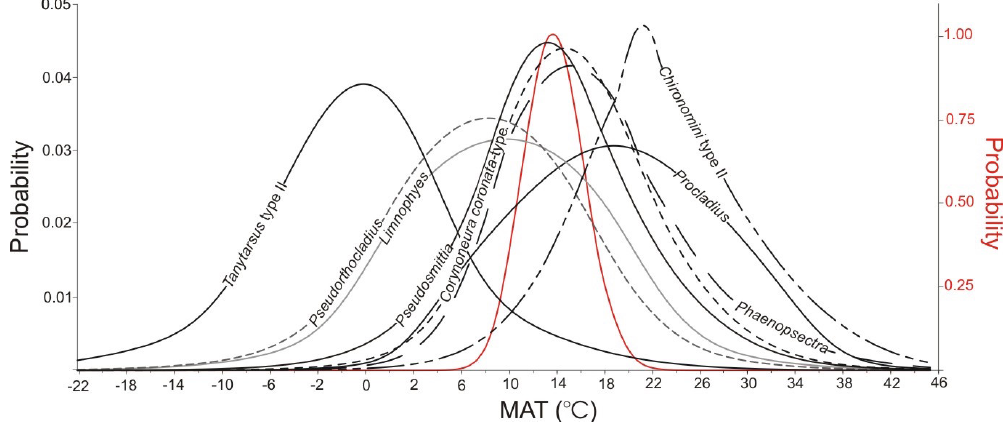
Figure 12. Individual likelihood functions for the fossil taxa in the coldest sample of the Laguna Pindo sequence (396cm total depth, ca. 2700calyrBP). The posterior probability distribution for temperature for the fossil sample is plotted in red; note that this is plotted on an independent